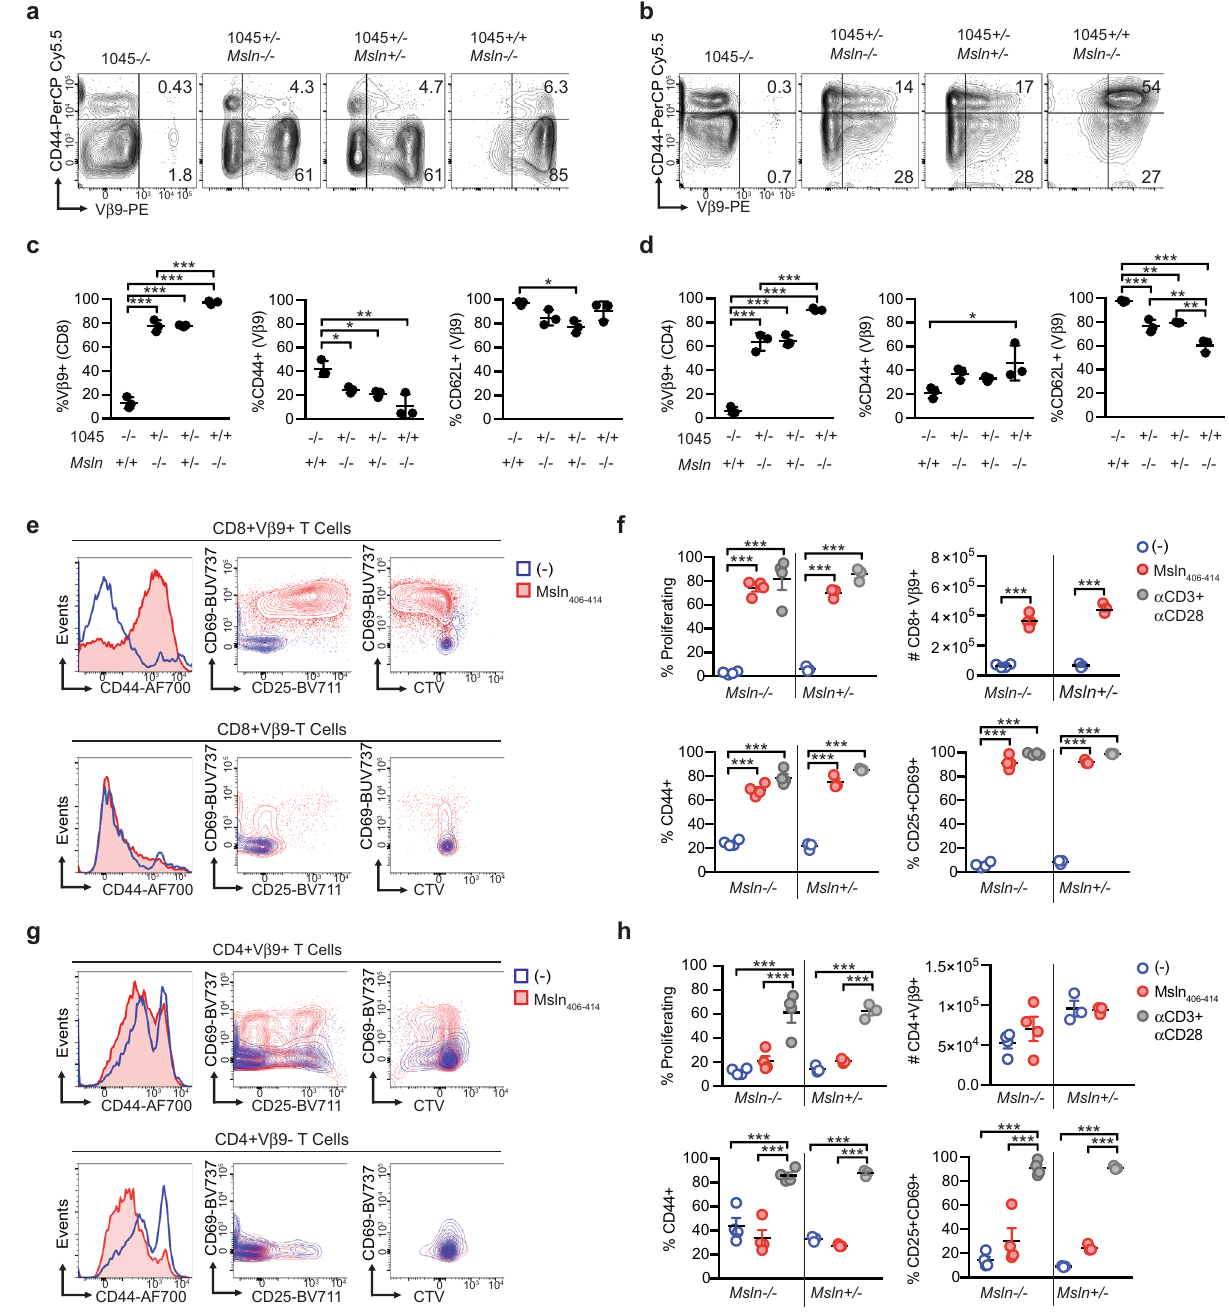
* p <0.05, ** p <0.005,*** p <0.0005. One-way ANOVA with a Tukey ’ s posttest. e Representative plots gated on CD8+V β 9+ (top row) or CD8+V β 9 − (bottom row) T cells on day 3 post±Msln 406-414 peptide. f Quanti fi cation of e and results post α CD3+ α CD28 on day 3. Data are mean±SEM. Each dot is an independent mouse. *** p <0.0005. One-way ANOVA with a Tukey ’ s posttest. g Representative p lots of CD4+V β 9+(toprow)orCD4+V β 9 − Tcells(bottomrow)onday3post±Msln 406-414 peptide. n =4 biologically independent experiments. h Quanti fi cation of g and results from post α CD3+ α CD28 on day 3. Data are mean±SEM. n =4 biologically independentexperiments. *** p <0.0005.One-wayANOVAwithaTukey ’